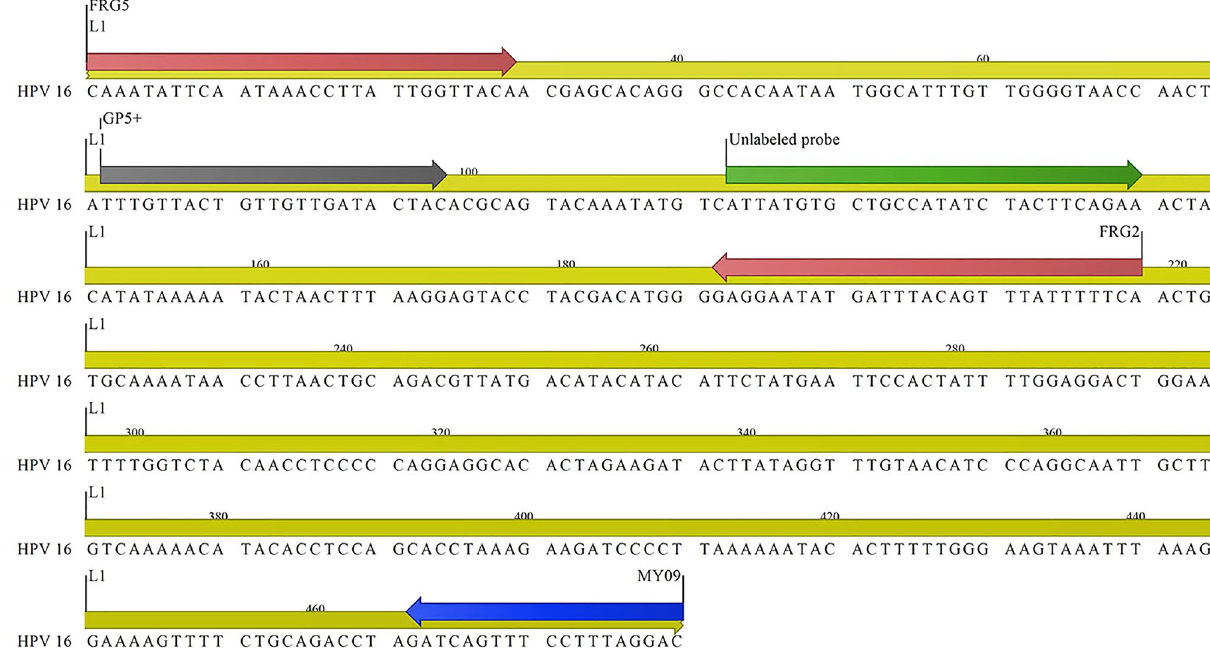
Figure 1. Schematic map of the L 1 region human papillomavirus, primers and unlabeled probe using CLC workbench 12 software.